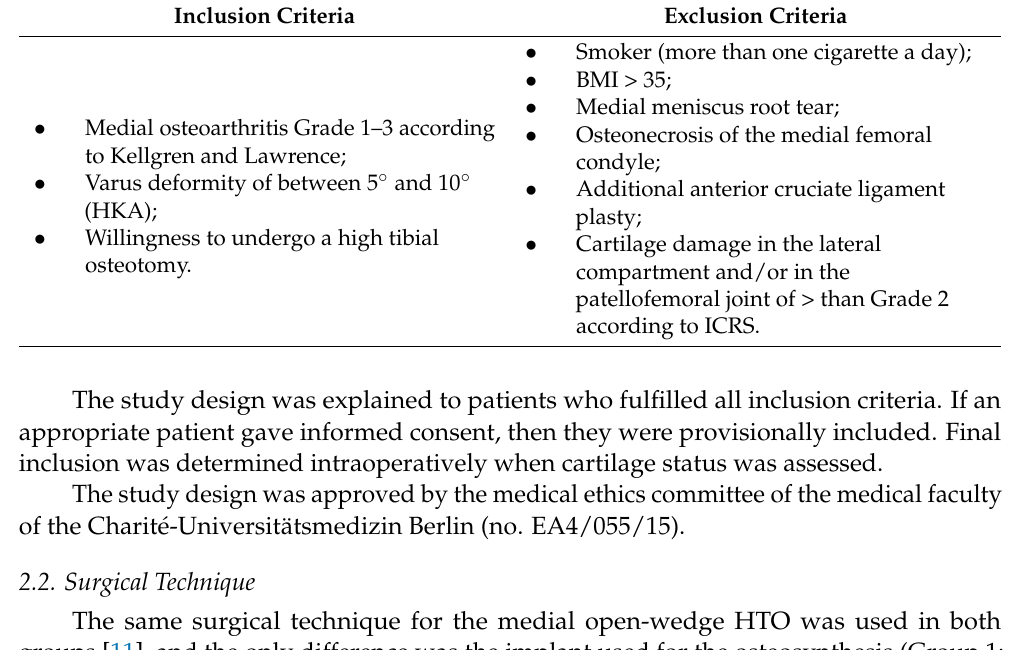
Table 1. Inclusion and exclusion criteria. Inclusion